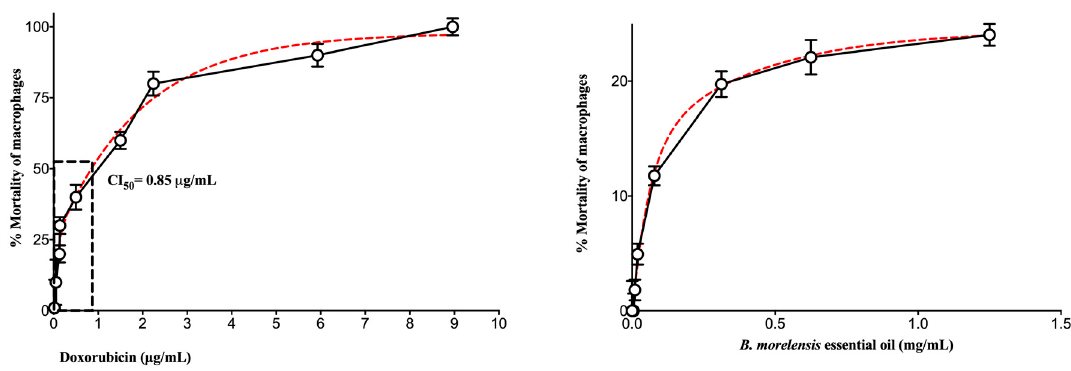
Figure 2. Cytotoxicity of B. morelensis oil compared with cytotoxicity of doxorubicin.